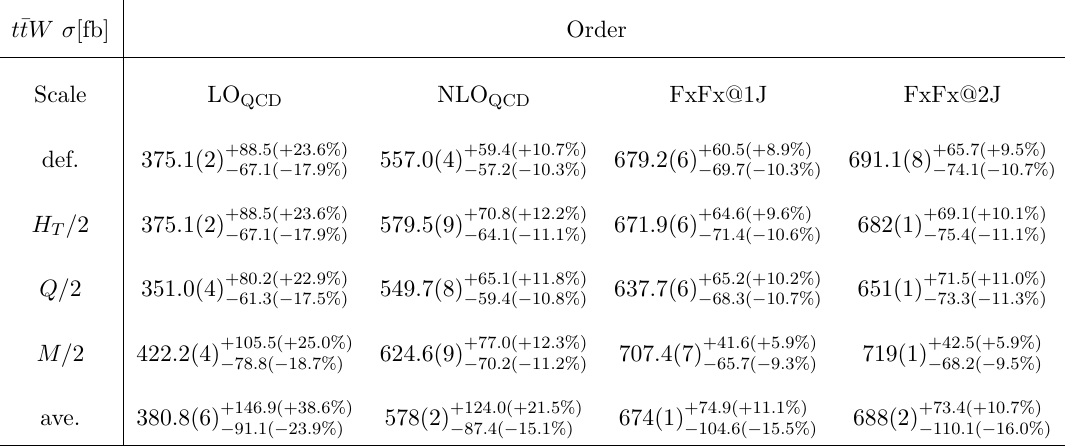
Table 3 . Cross section comparisons for t ¯ tW using different scale definitions. The error in paren- thesis is the absolute MC-error on the last digit of the central value. The scale uncertainties are shown in the form of ±{ absolute } ( ±{ relative in % } )